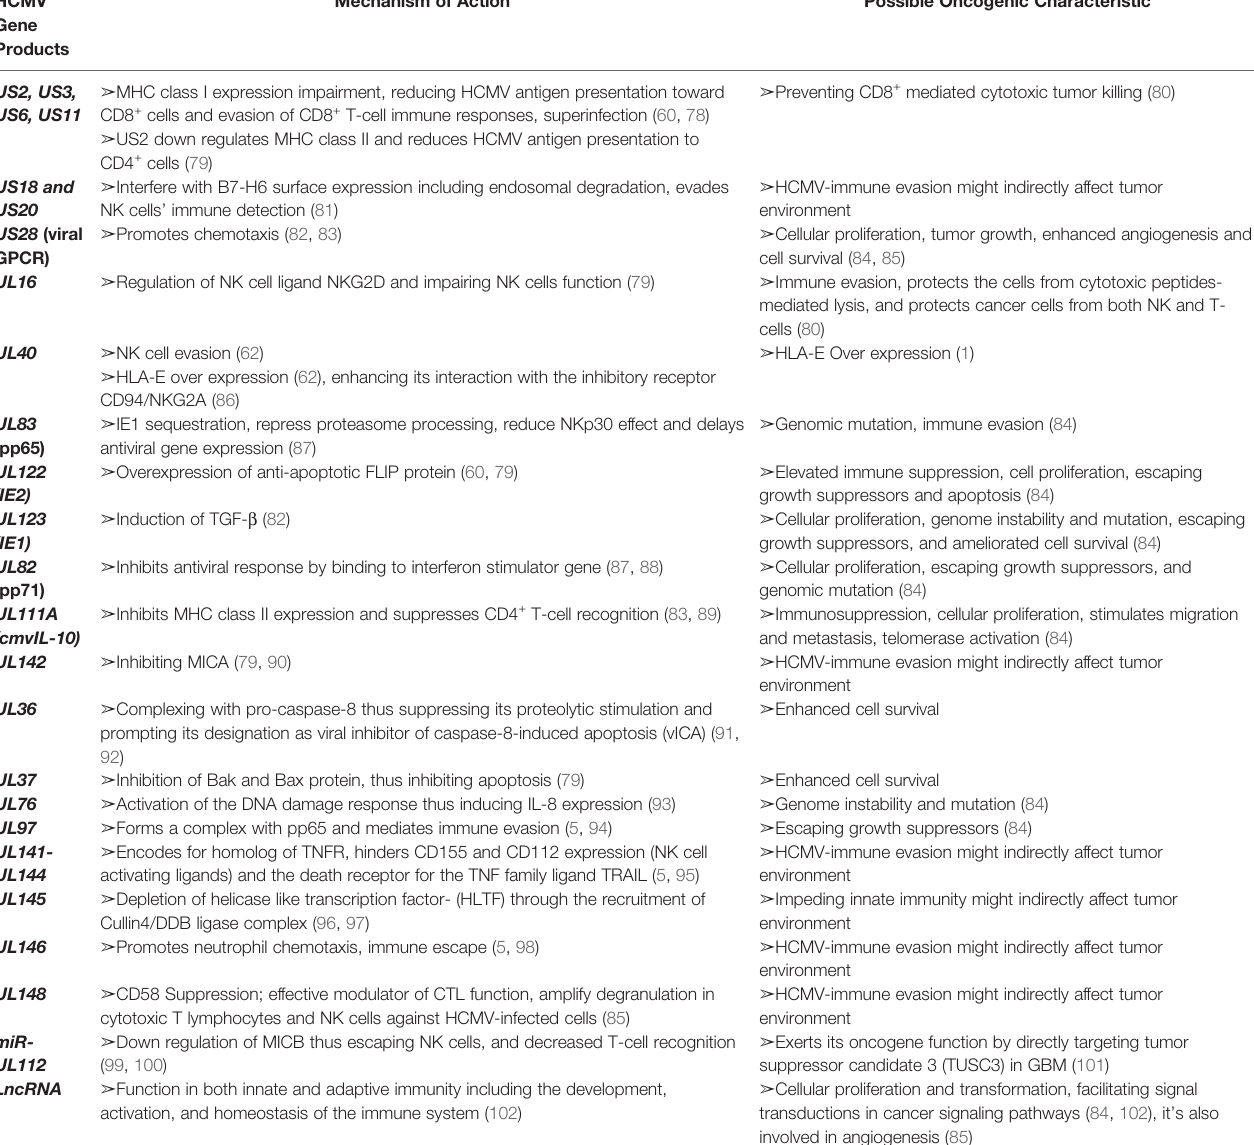
TABLE 1 | HCMV gene products involved in immunomodulation and their oncogenic characteristics. HCMV Mechanism of Action Possible Oncogenic Gene Products